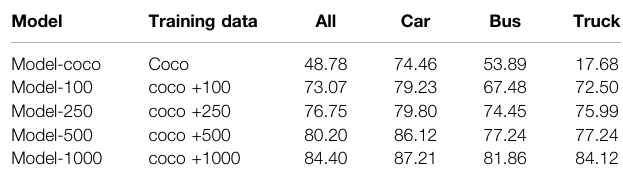
TABLE 1 | Information on traf fi c videos. TABLE 2 | Vehicle detection accuracy of each model